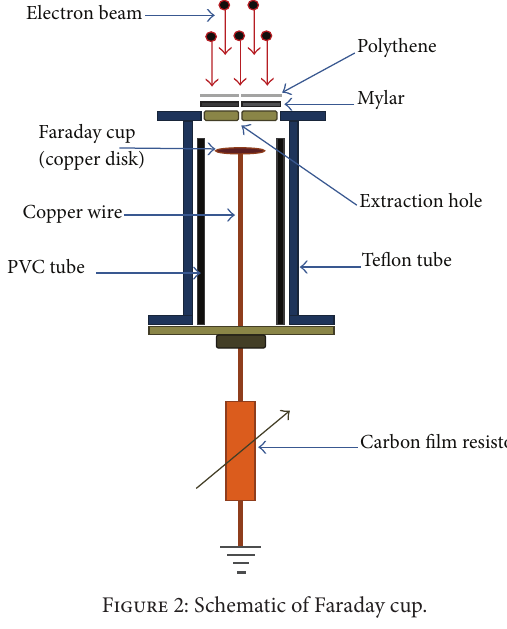
Figure 1: Schematic of plasma focus device.